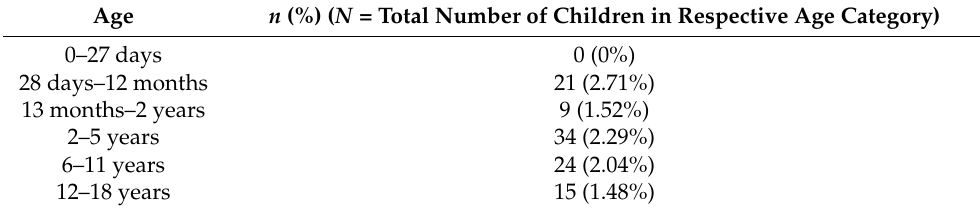
Table 12. Occurrence of adverse events according to age of the